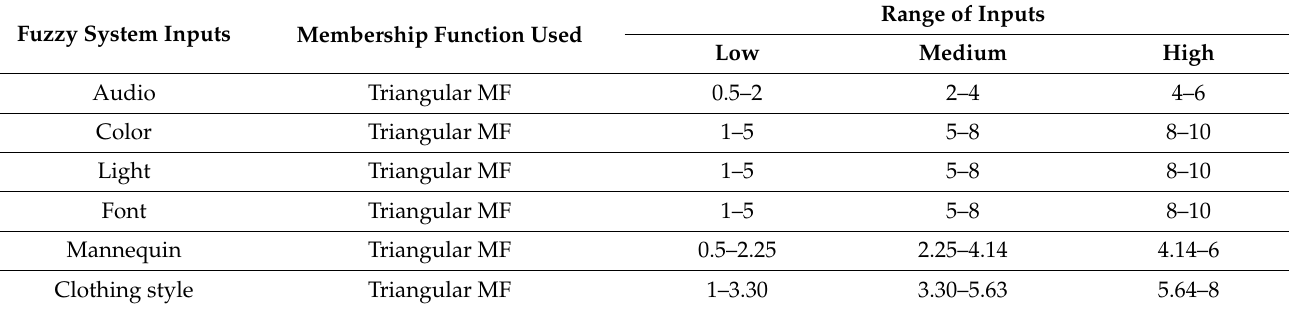
Table 1. Membership functions of fuzzy system inputs.